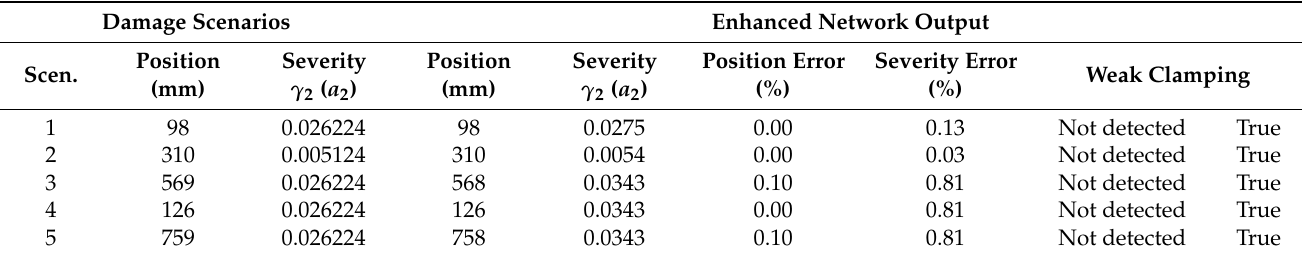
Table 15. Obtained results using the precision sector ANN.